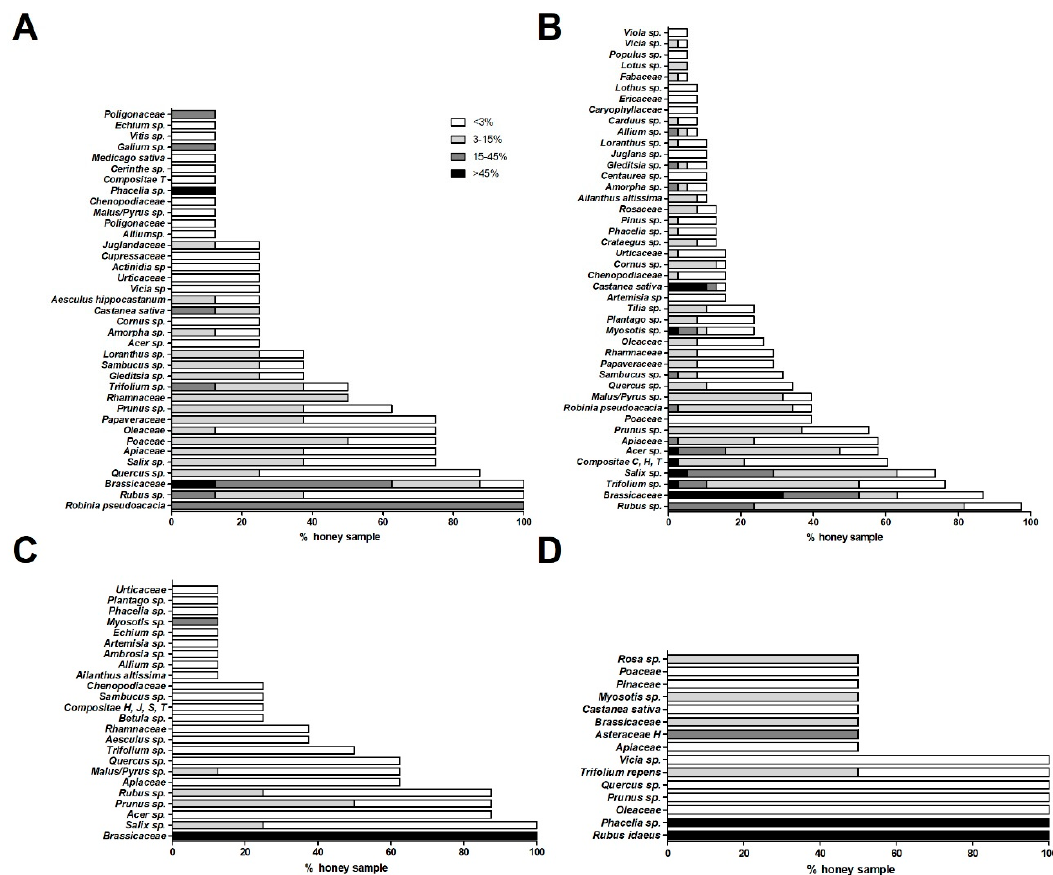
Figure 1. Pollen spectra of di ff erent types of honey-acacia ( A ), wildflower ( B ), rapeseed ( C ), and phacelia and raspberry ( D ) are given. For each graph, the percentage of honey samples showing di ff erent pollen types (family, genus, or species) with relative abundance frequency ( > 45%; 15–45%; 3–15%; and < 3%) are shown.